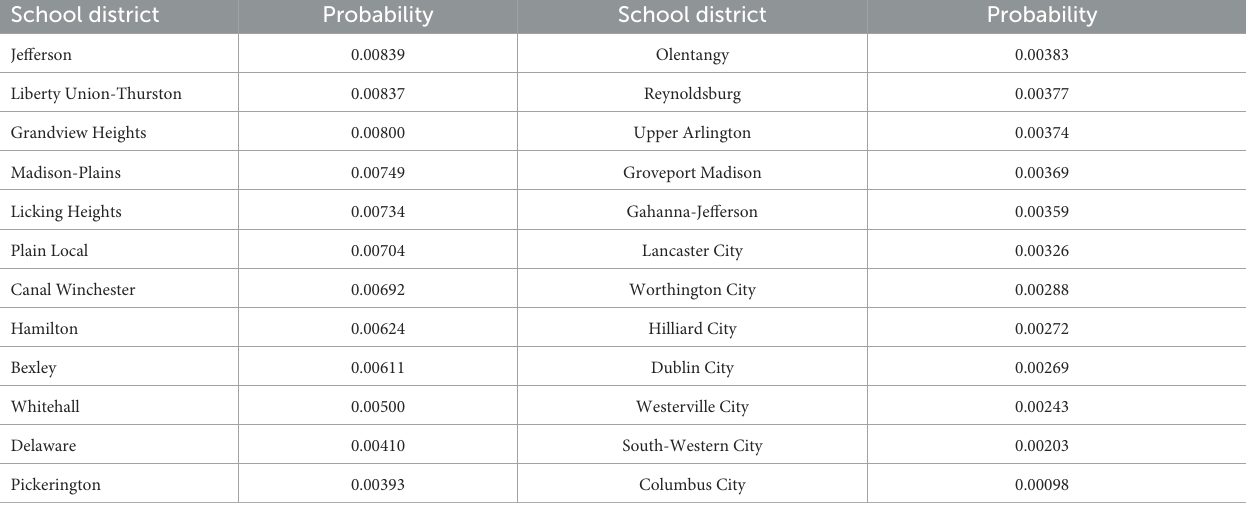
TABLE 1 Probability of being a decisive voter in a Columbus Ohio school district in 2000.